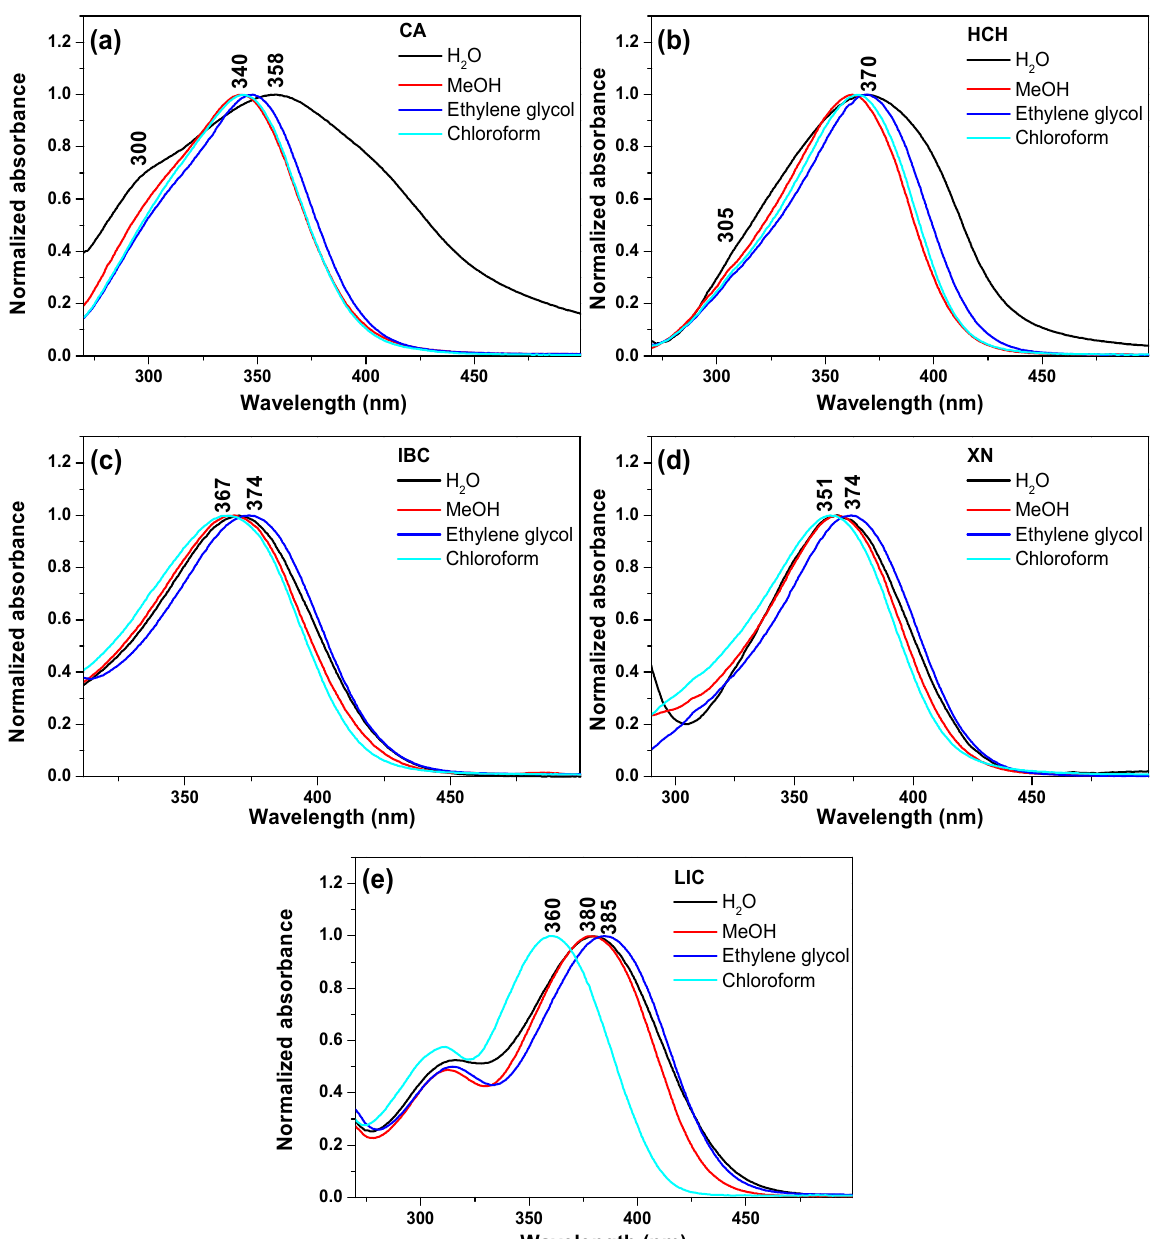
Figure 1. Normalised UV–vis absorption spectra of chalcones in various solvents: H 2 O, methanol, ethylene glycol and chloroform. ( a ) CA, ( b ) HCH, ( c ) IBC, ( d ) XN and ( e ) LIC.